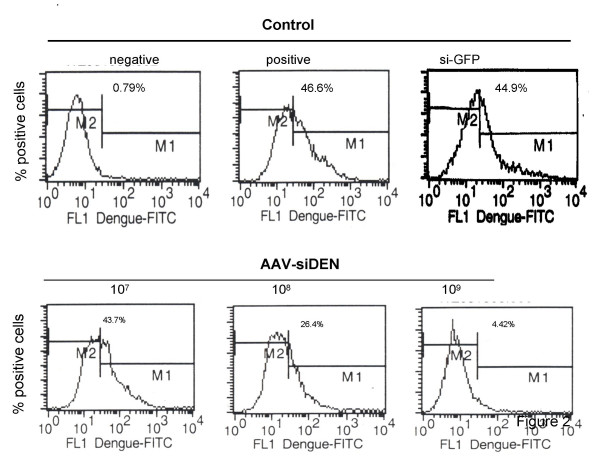
AAVsiDEN expression decreases DEN-2 virus infection in cultured Vero cells. Cells were infected with different amounts (PFU/ml) of AAV carrying the siDEN3UT silencing cassette and after 2 days the cells were infected with DEN-2 virus (MOI of 0.1). Five days later, the numbers of DEN-2 virus infected cells were measured by flow cytometry.